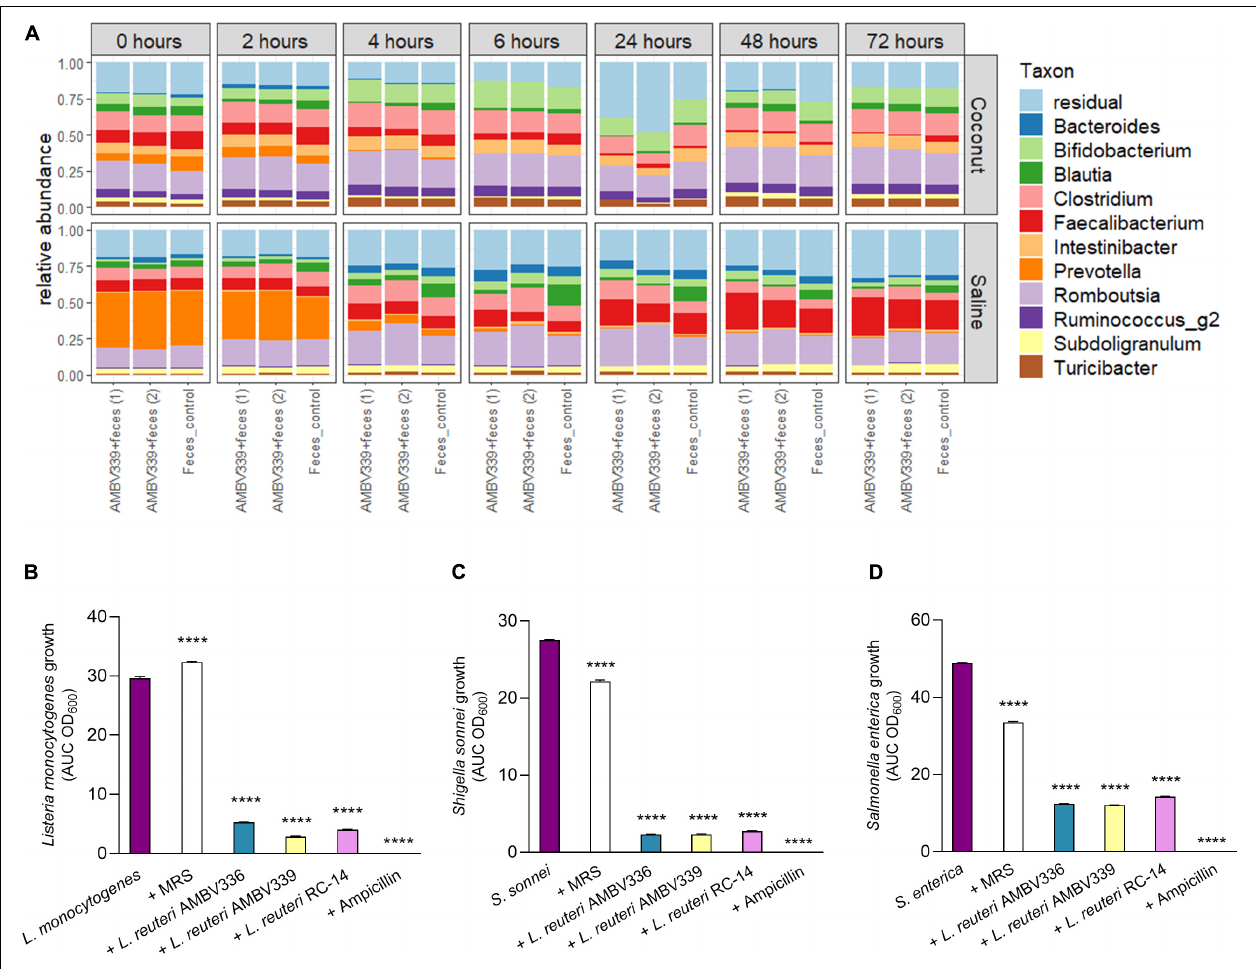
FIGURE 6 | (A) Relative taxonomic abundances based on 16S rRNA amplicon sequencing of colon samples to evaluate the influence of L. reuteri AMBV339 resuspended in saline or as culture in a fermented coconut beverage on fecal microbiota in the GIDM-colon system. Taxonomic composition of the fecal microbiome on genus-level for L. reuteri AMBV339 in saline or coconut culture (in duplicate) and feces control grouped per time point. L. reuteri AMBV339 reads were removed, and top 11 genera are visualized, the other taxa are grouped in residual. (B–D) Growth inhibition of enteric pathogens (B) Listeria monocytogenes , (C) Shigella sonnei , and (D) Salmonella enterica under influence of supernatants of L. reuteri AMBV336, L. reuteri AMBV339, and L. reuteri RC-14 in MRS. Supernatants were added at 1:5 dilution and MRS medium was used as control. Data is presented as area under the growth curve (AUC) means ± SD per condition based on